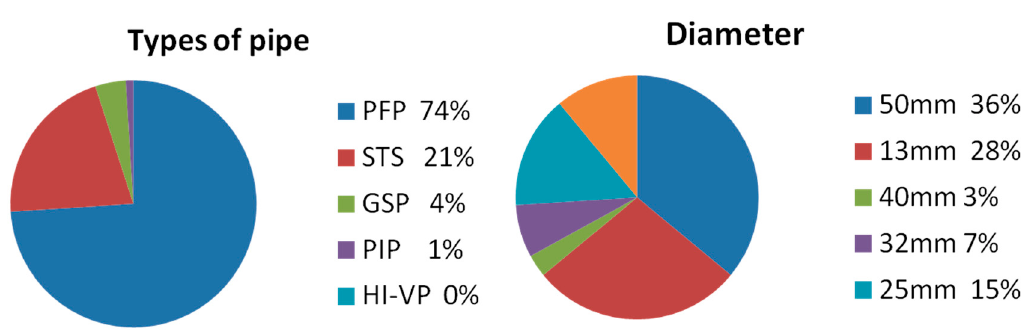
Table 3. Inventory composition of Level 1.